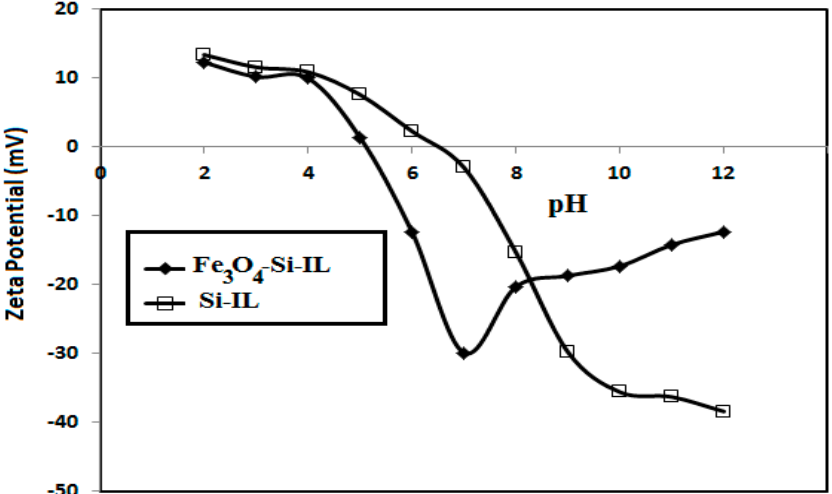
Figure 5. Relationship between zeta potential (mV) and pH of aqueous solution dispersions of Fe 3 O 4 -Si-IL and Si-IL.